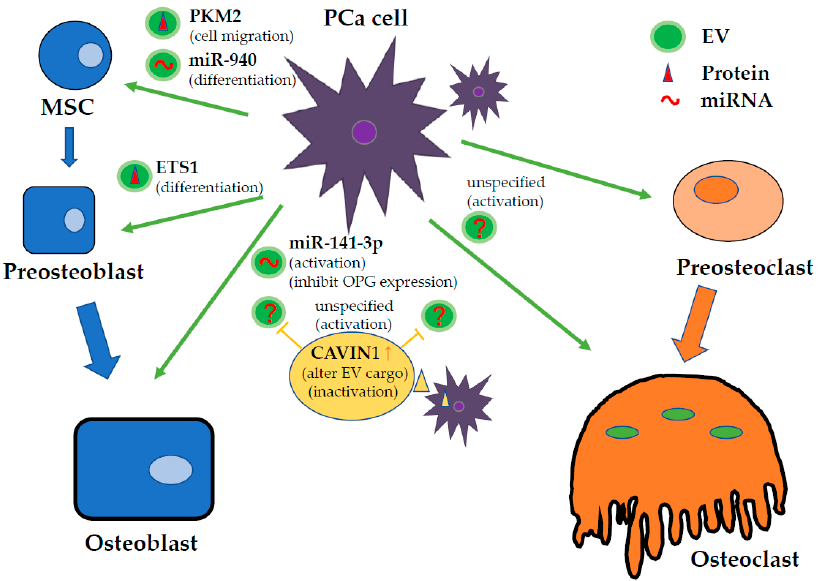
Figure 2. The main functions of EV cargo derived from PCa cells in the bone tumor microenvironment. EVs secreted by PCa change the beneficial bone remodeling cycle into a vicious cycle, affecting bone cells. Recent investigations reported that EVs derived from bone cells also affect cancer cell viability. It is thought that EV functions in the bone tumor microenvironment are very complex.